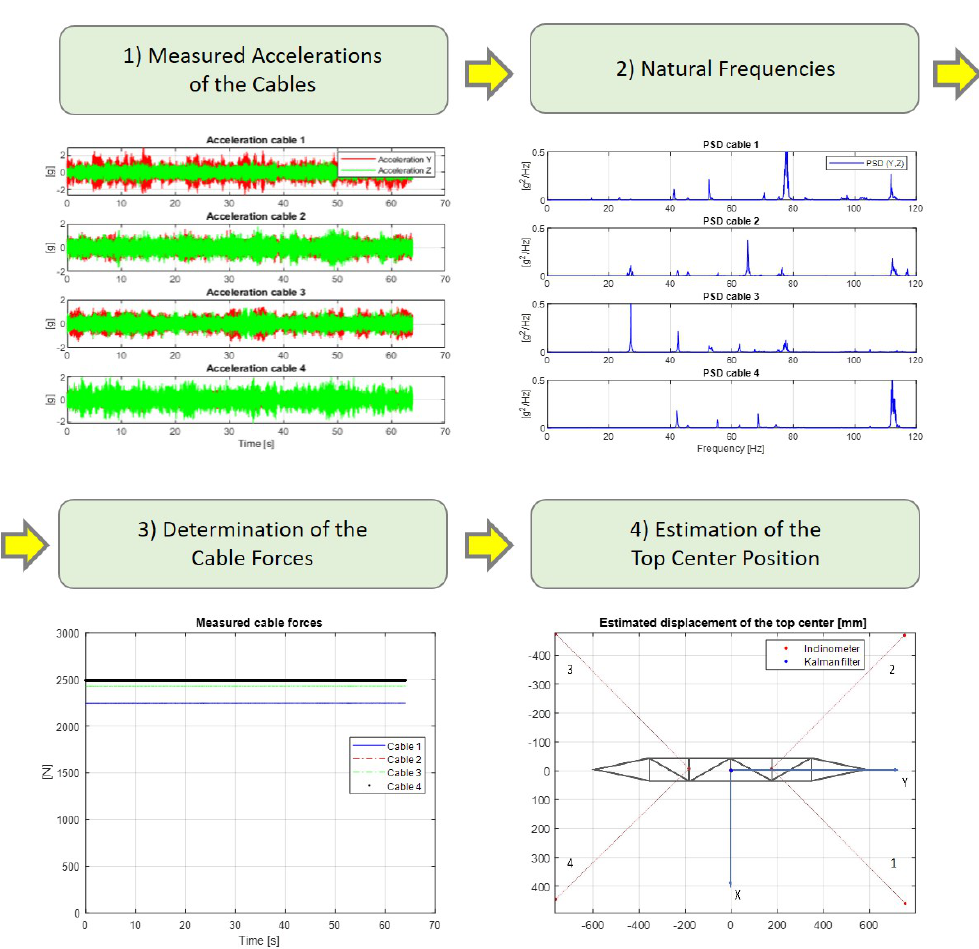
Figure 22. Scheme of the procedure for the estimation of the tower top center